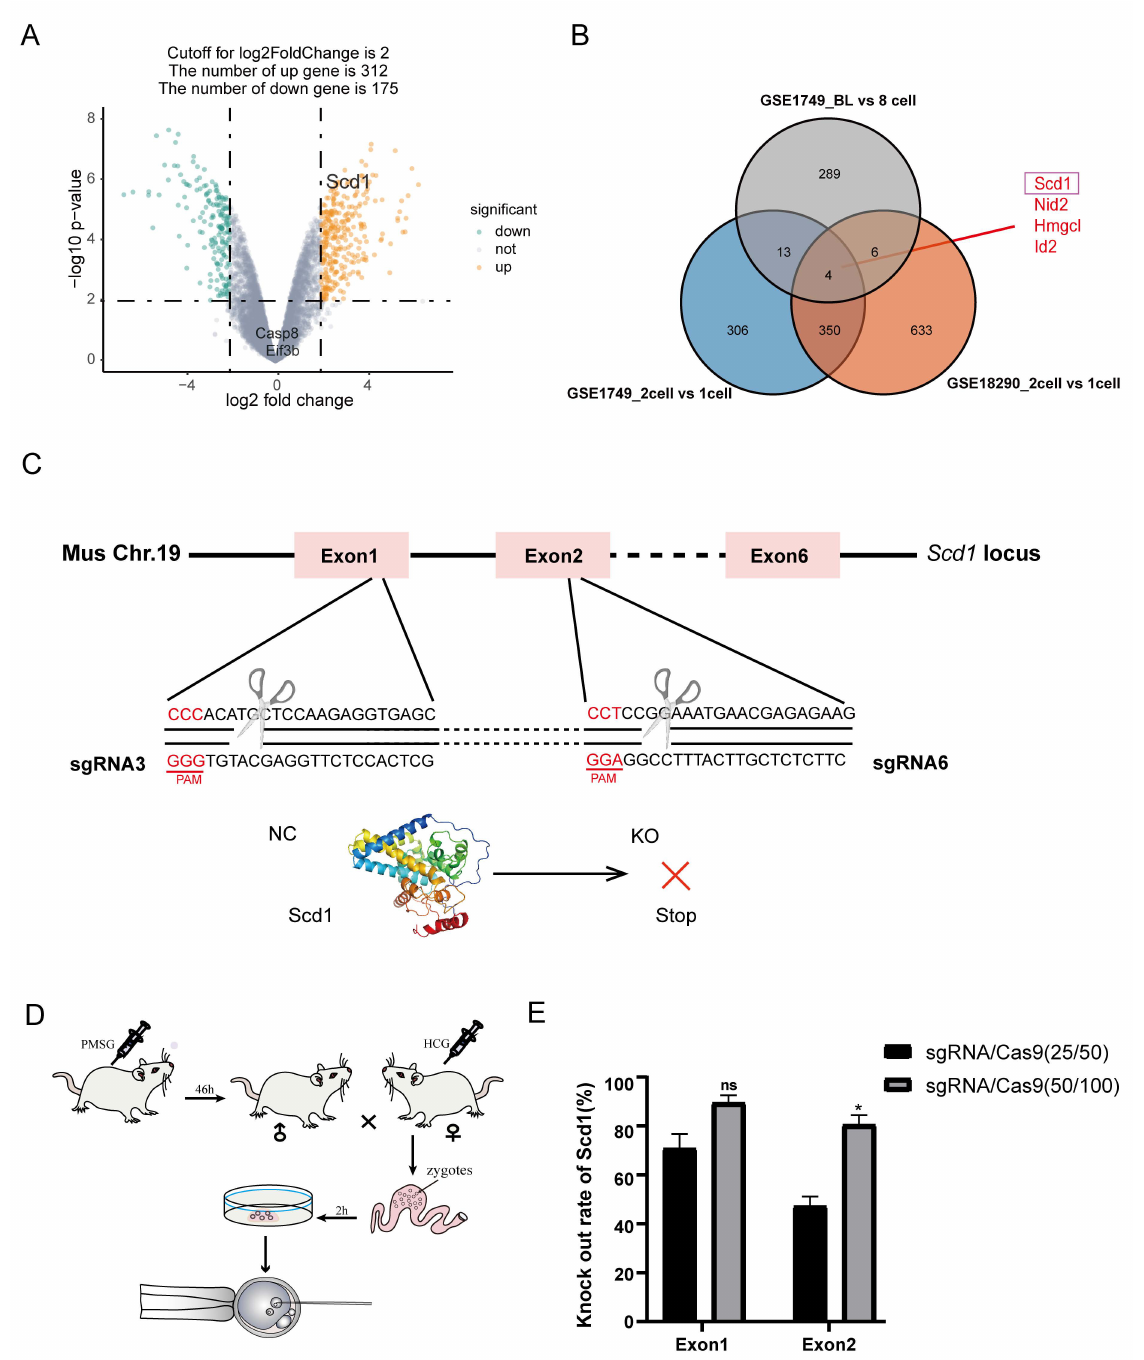
Figure 1. Expression of Scd1 gradually increases as embryonic development. ( A ): The Volcano map of differentially expressed genes (DEG) of GSE1749, a data set characterizing embryonic development. ( B ): Venn diagram showing genes co-upregulated in 2-cell and blastocyst stages in GSE1749 and GSE18290. ( C ): The target sites of sgRNA3 and sgRNA6 on Scd1 gene locus. ( D ): Schematic diagram of embryo collection and microinjection. ( E ): Comparation of Scd1 gene knock out efficiency between two different concentrations of sgRNA/Cas9 (sgRNA:25 ng/ µ L, Cas9:50 ng/ µ L; sgRNA:50 g/ µ L, Cas9:100 ng/ µ L) at exon1 and exon2. Two-tailed Student’s t -tests were used for statistical analysis, * p < 0.05; ns, not significant ( p >